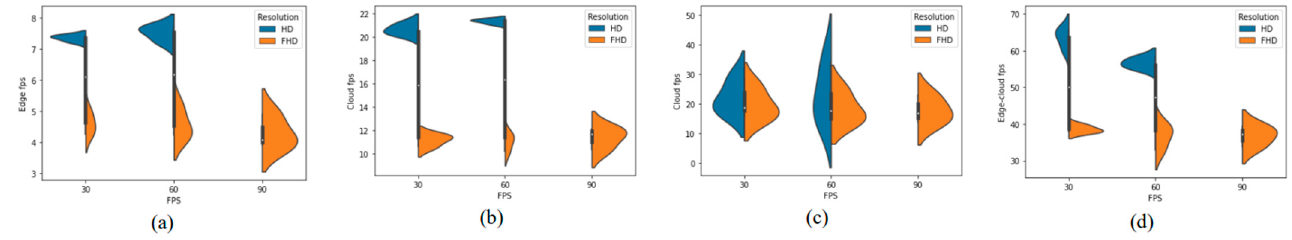
Figure 6. Violin plot of the processing speed achieved on the ( a ) edge, ( b ) cloud 1, ( c ) cloud 2, and ( d ) edge-cloud for each input video FPS and resolution.